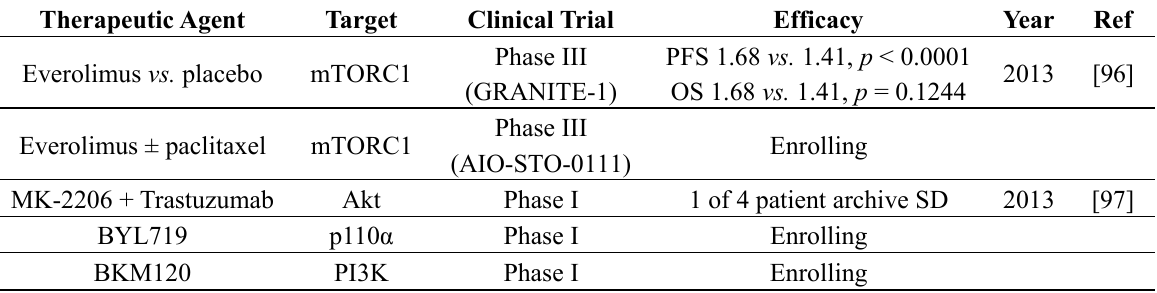
Table 2. Clinical trials investigating target agents for gastric